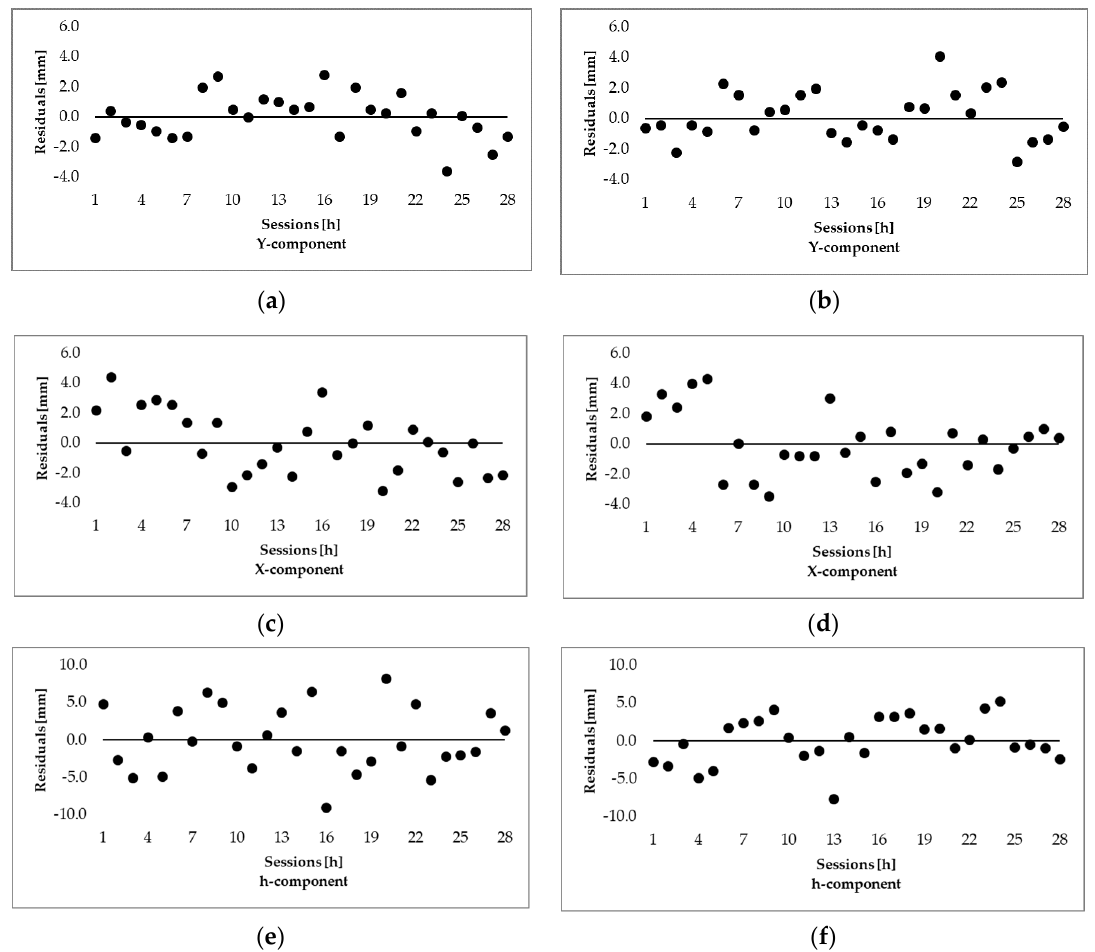
Figure 6. Baseline residuals for all coordinate components and both baselines: ( a ) Y component, G-